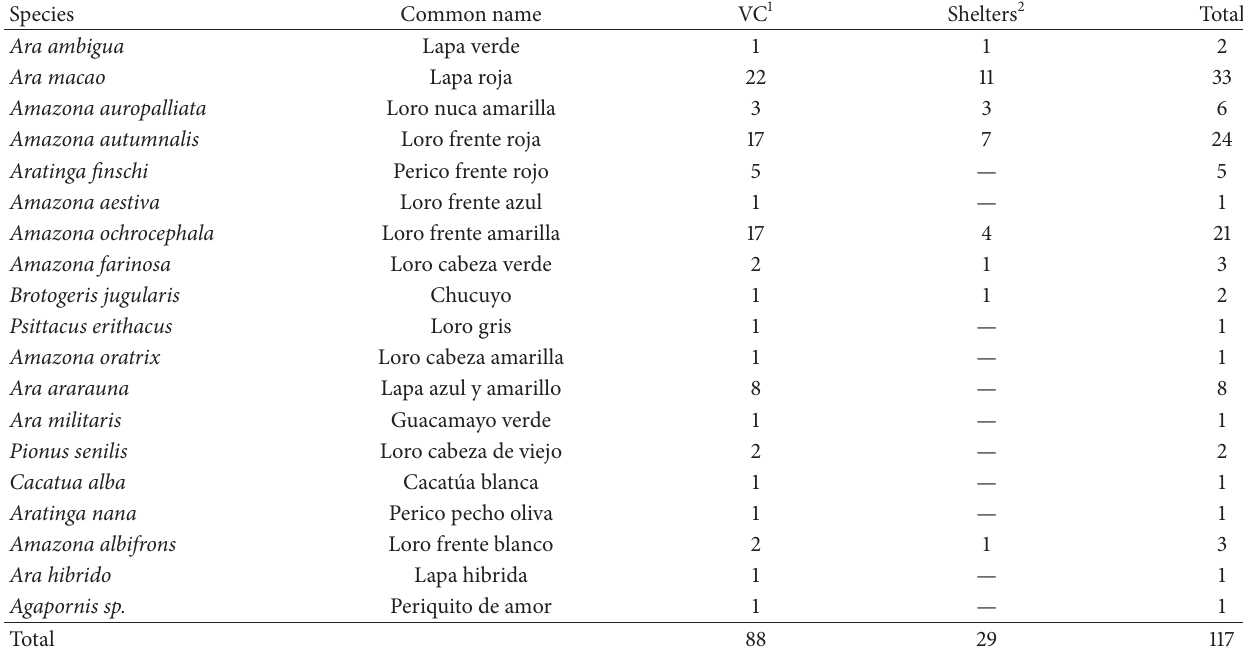
1 VC: birds submitted to veterinary clinics. 2 Shelters: birds from shelters or rescue